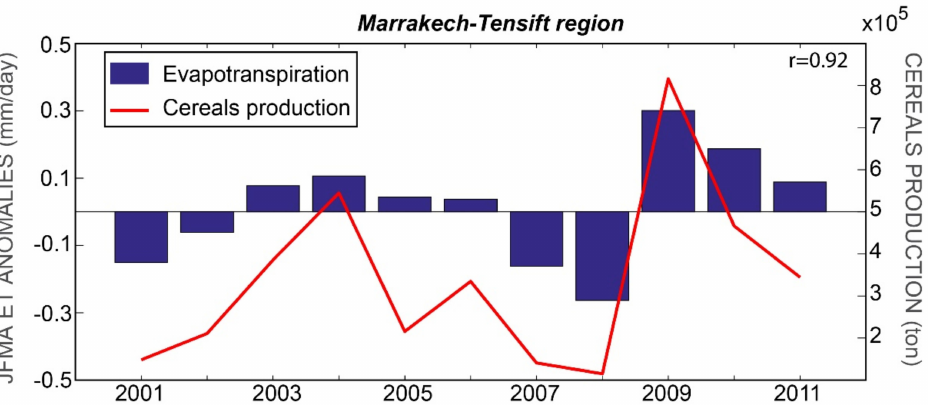
Figure 7. Comparison of evapotranspiration anomalies (monthly anomalies during the January– February–March–April growing season) in relation to cereal production (in tons) in the Tensift region over the 2001–2011 period.